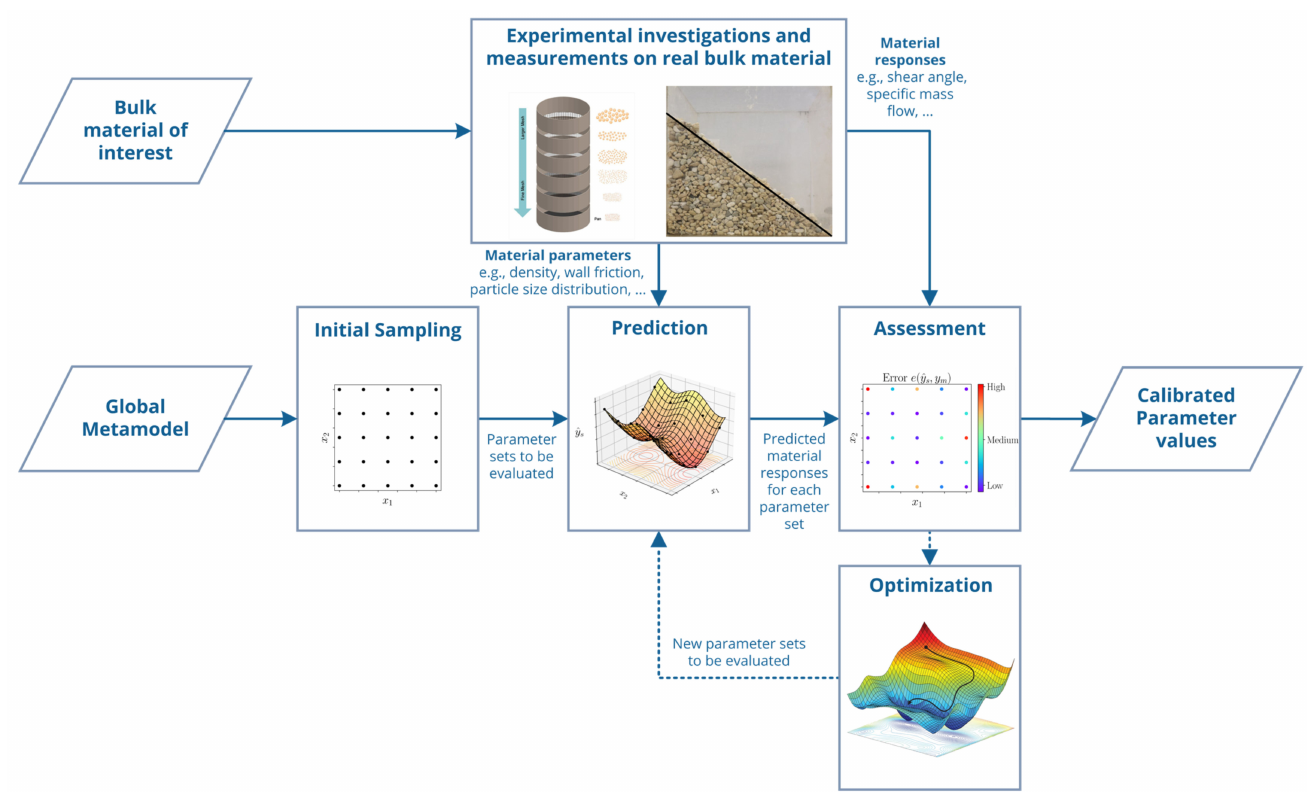
Figure 2. Scheme of metamodel-based global calibration